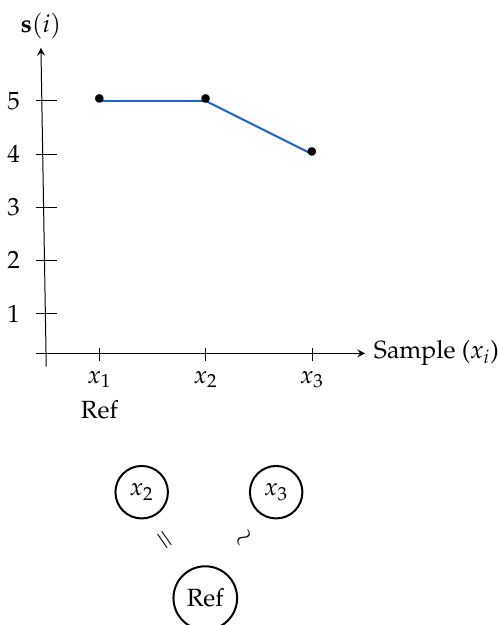
Figure 6. Example of scores describing that there is no significant difference between x 3 and the reference sample x 1 (equivalently, its identical to sample x 2 ) and where a threshold (cid:101) = 1 is